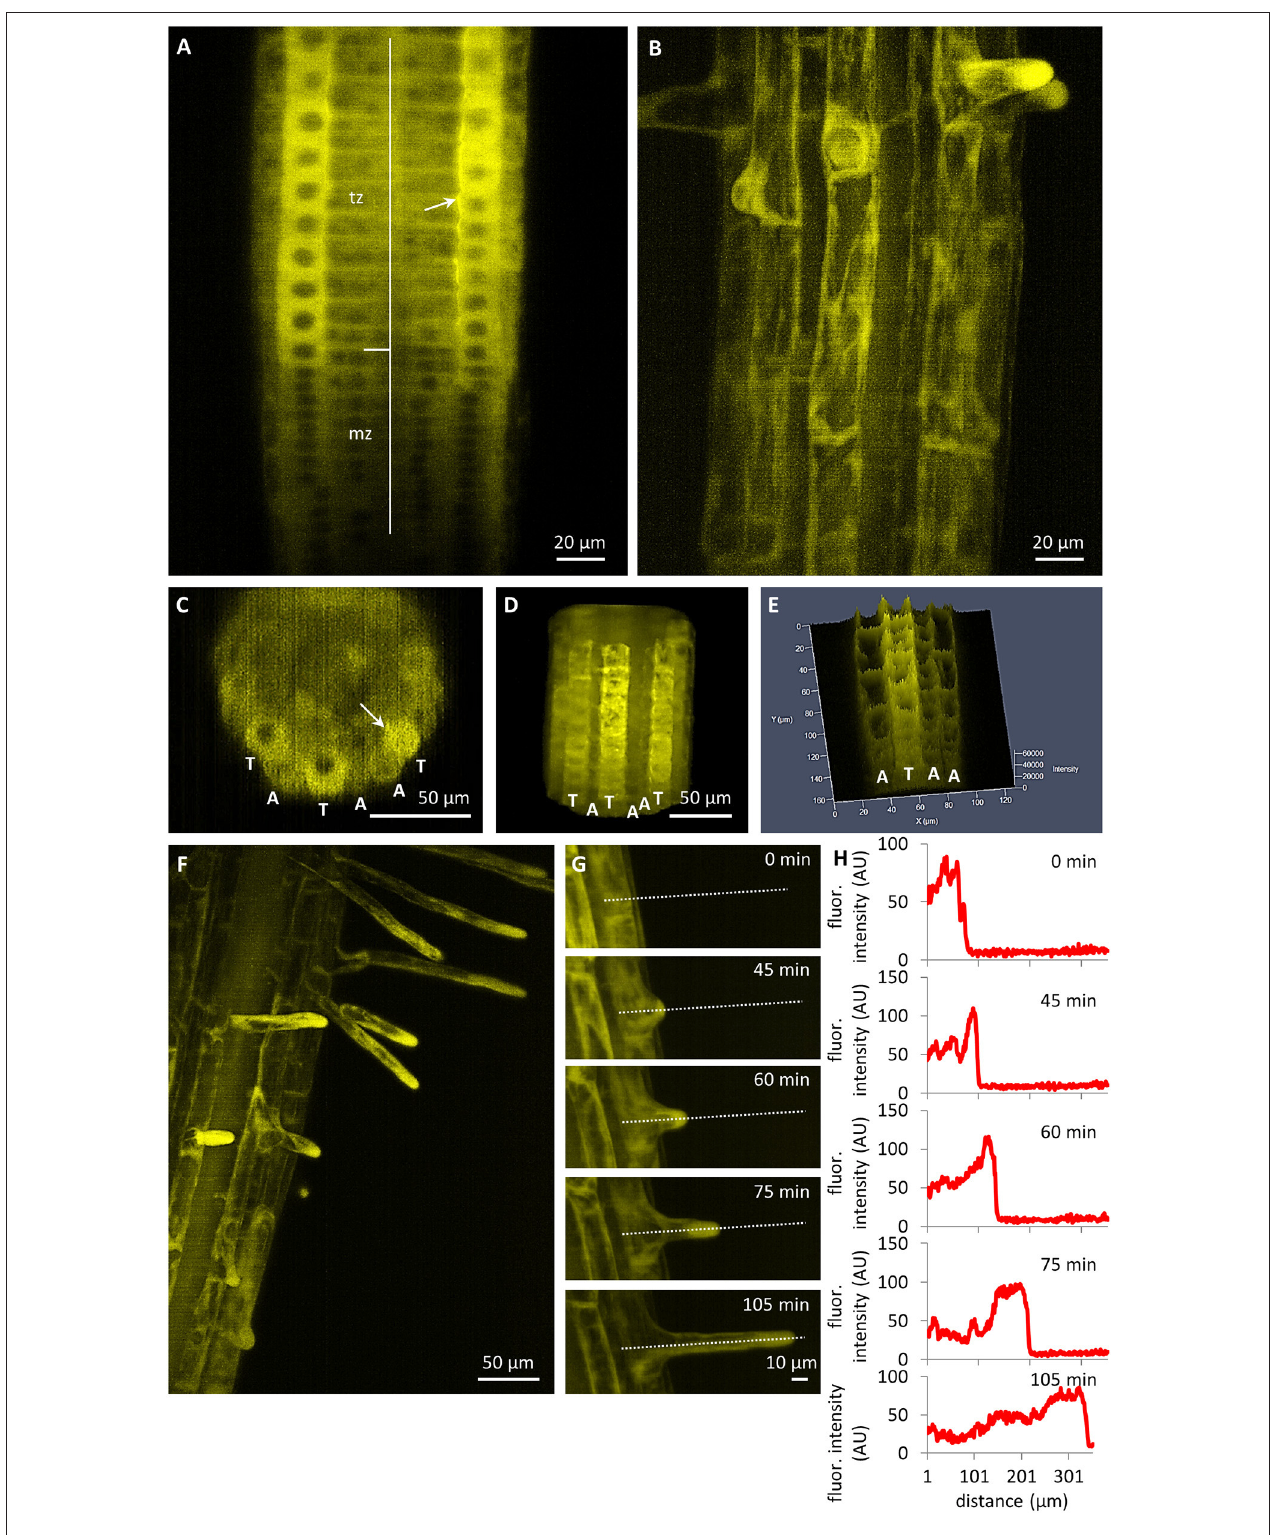
FIGURE 4 | Tissue- and cell-specific localization of PLD α 1-YFP driven by its own native promoter in the root of Arabidopsis thaliana by light-sheet fluorescence microscopy. (A) Distribution of PLD α 1-YFP in meristematic zone (mz) with relatively low expression and in transition zone (tz) with enhanced expression.